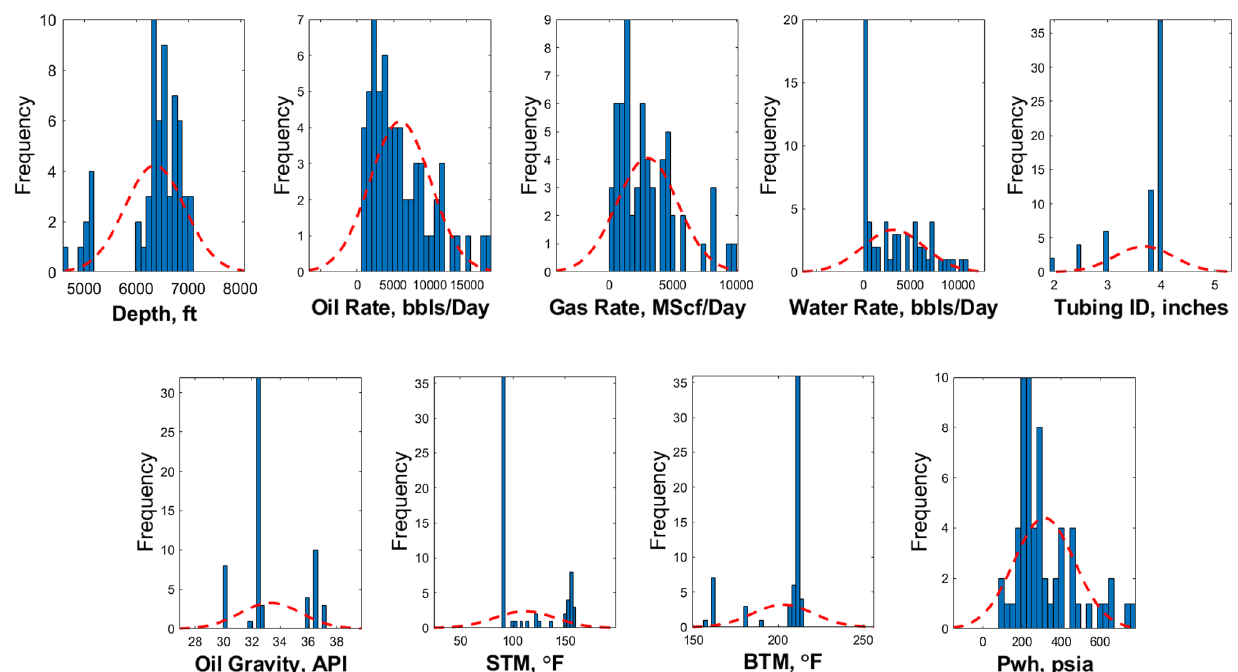
Fig. 3 Frequency histograms of testing dataset (60 data